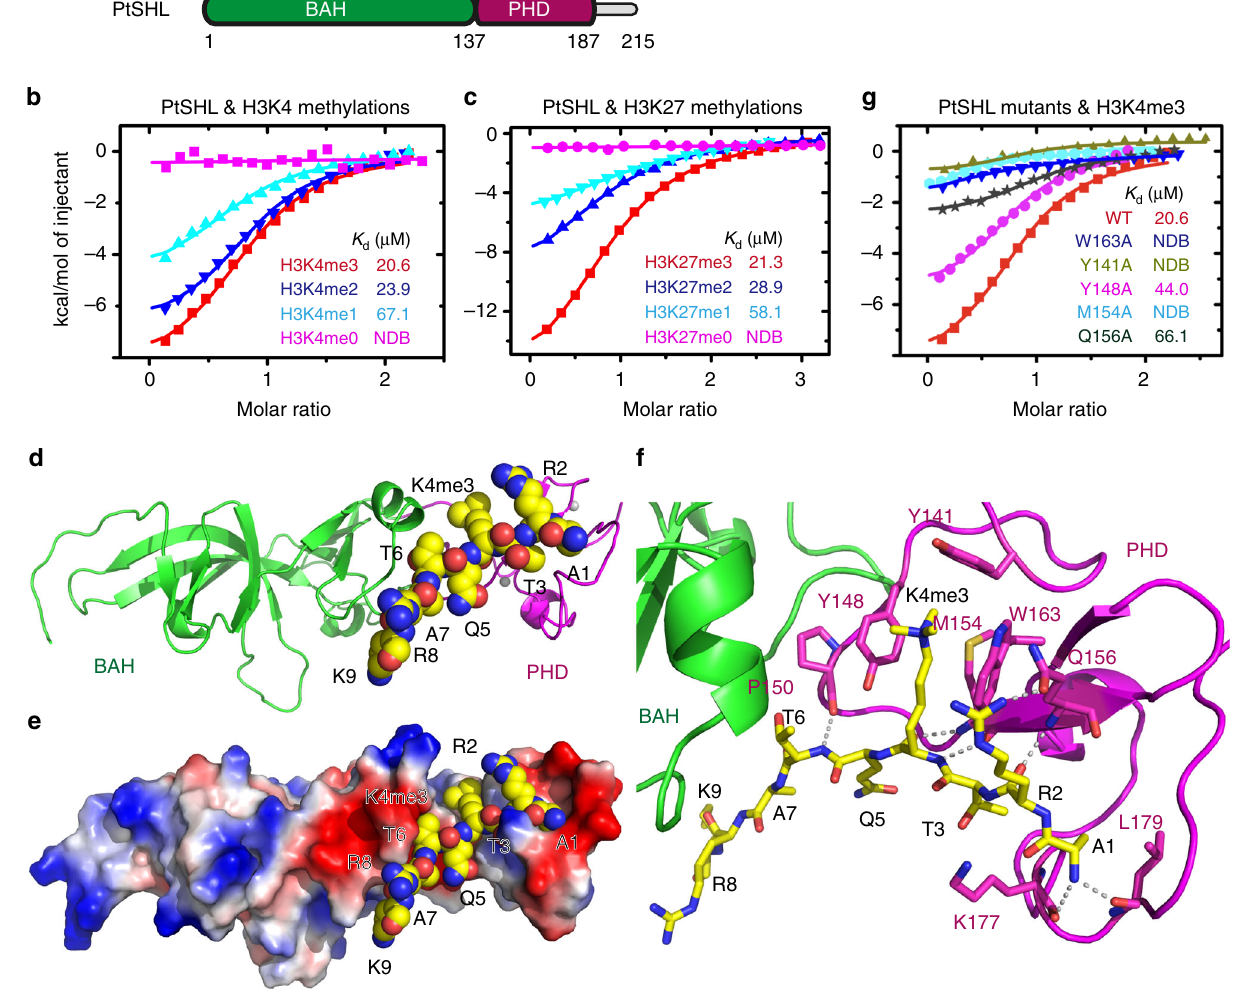
Fig. 2 Structure of PtSHL in complex with H3K4me3. a The domain architecture of Populus trichocarpa SHL (PtSHL). BAH, bromo-adjacent homology; PHD, plant homeodomain. b, c ITC binding curves for the complex formation between PtSHL and different H3K4 (b) and H3K27 (c) methylated peptides. d Overall structure of PtSHL-H3K4me3 complex with the BAH and PHD domains colored in green and magenta, respectively. The peptides and zinc ions are shown as spacing fi ll model and silver balls, respectively. e Electrostatic surface view of the PtSHL in complex with H3K4me3. f The detailed interactions between PtSHL and H3K4me3 with the peptide shown in stick model. The hydrogen bonds are highlighted by dashed lines. g ITC binding curves show that the mutations of key residues critical for H3K4me3 binding signi fi cantly decrease the binding af fi nity to the H3K4me3 peptide. NDB, no detectable